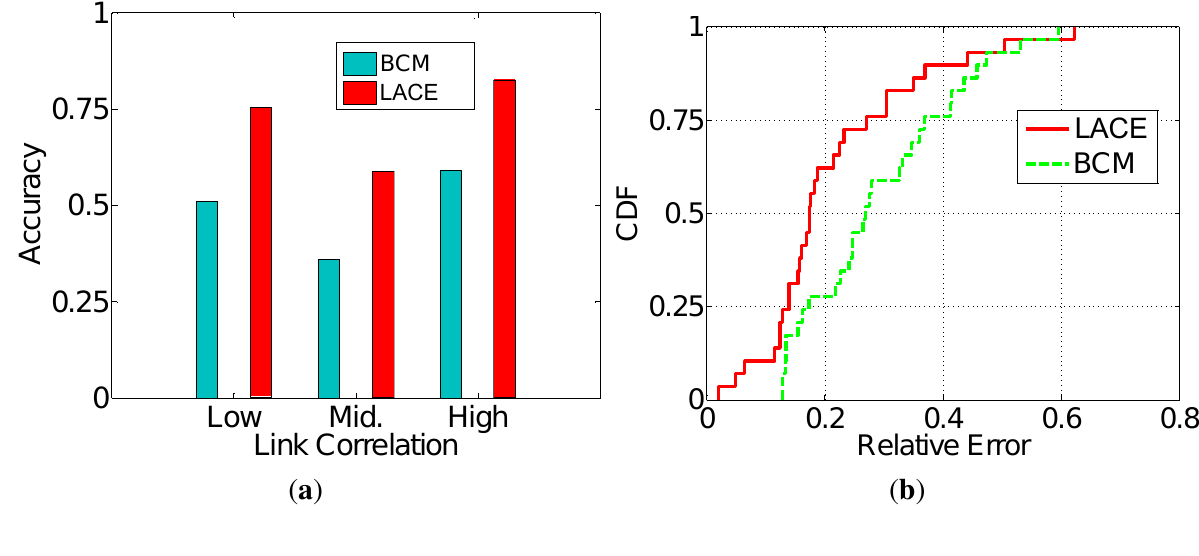
Figure 4. Accuracy of link correlation estimation. ( a ) Average estimation accuracy; ( b ) Variability of estimation